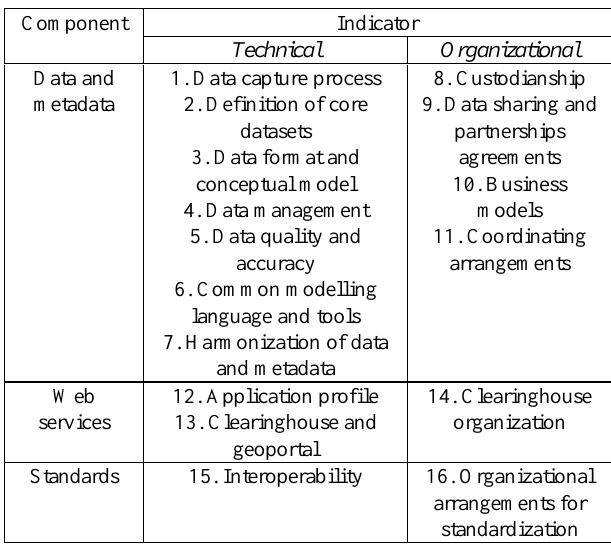
Table 1. Indicators for comparing SDIs on the basis of